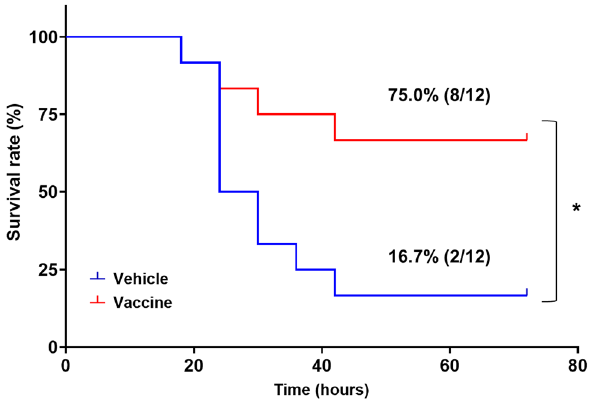
Figure 3. Effects of PAI-1 vaccine on survival rate in a mouse model of LPS-induced severe sepsis. Mice (n = 12 per group) immunized with PAI-1 vaccine or KLH vehicle received 15 mg/kg LPS and were subsequently monitored for survival for 72 h. Data are expressed as mean ± SEM (error bars). Survival was visualized by using the Kaplan–Meier method, and differences in survival were evaluated by using the log-rank test. * P < 0.05 compared with the value for the vehicle-treated